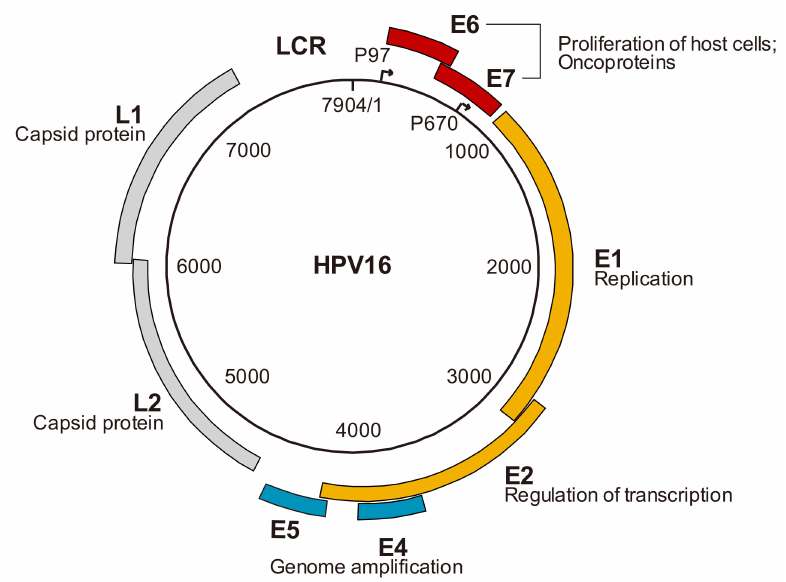
Figure 1. Genome organization of human papillomavirus (HPV) 16 and function of viral gene products. Schematic representation of the HPV16 genome shows location of early (E) and late (L) genes, and of the long control region